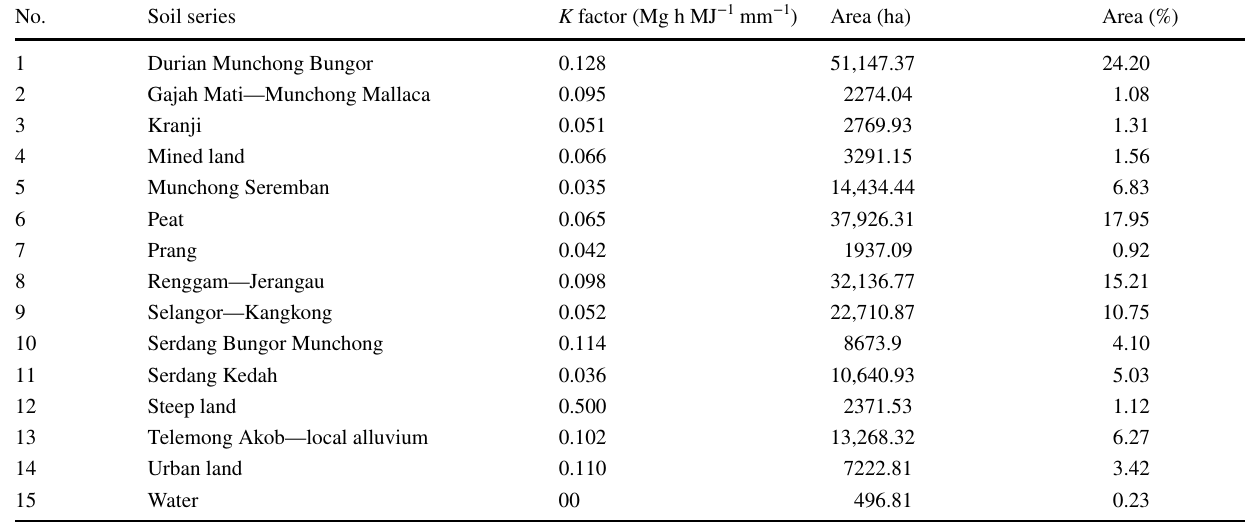
Table 6 Spatial distribution of soil series and corresponding K factor at the study area. Source: Ministry of Natural Resources and Environment Malaysia (2010) No. Soil